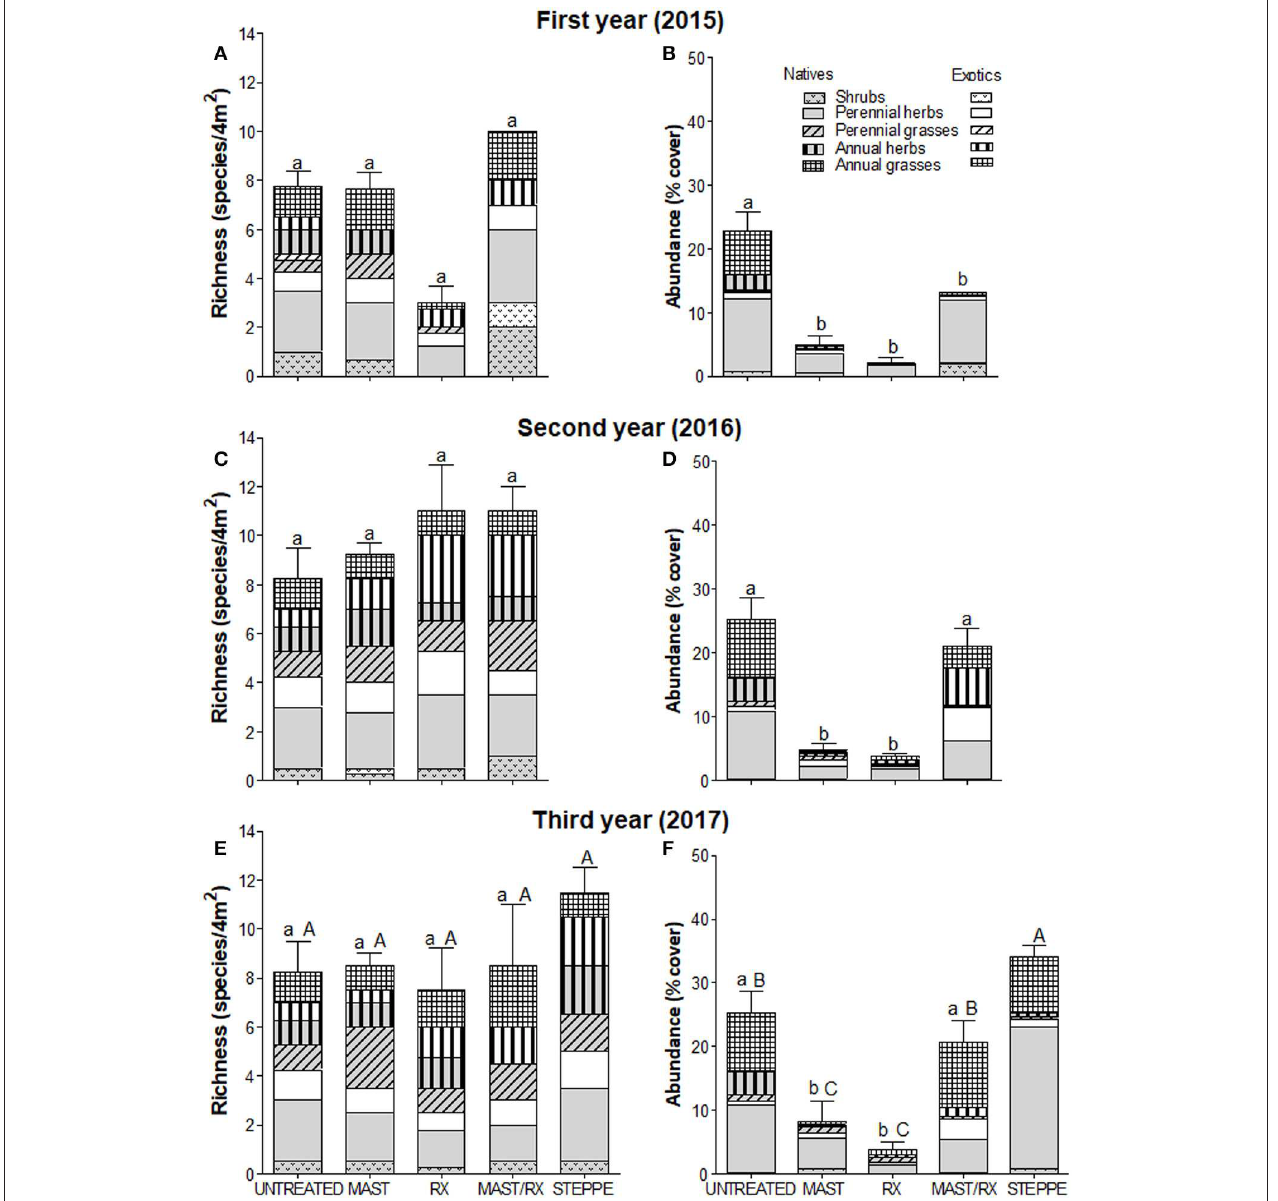
FIGURE 6 | Vegetation richness (A,C,E) and abundance (B,D,F) by origin and growth form in each fuel treatment for the first (A,B) , the second (C,D) , and the third (E,F) years; steppe vegetation variables are included for the third year in site 3. Bars indicate total richness and abundance SE , respectively. Different small letters indicate differences among fuel treatments for each year (differences among years for each fuel treatment are not represented), and capital letters indicate differences among fuel treatments and steppe. Treatments are as follows: residues on the floor (UNTREATED), mastication (MAST), prescribed fire (RX), mastication plus prescribed fire (MAST/RX), and steppe vegetation